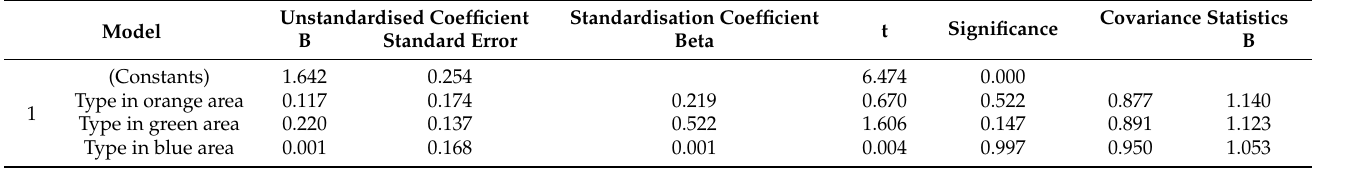
Table 7. Parameter